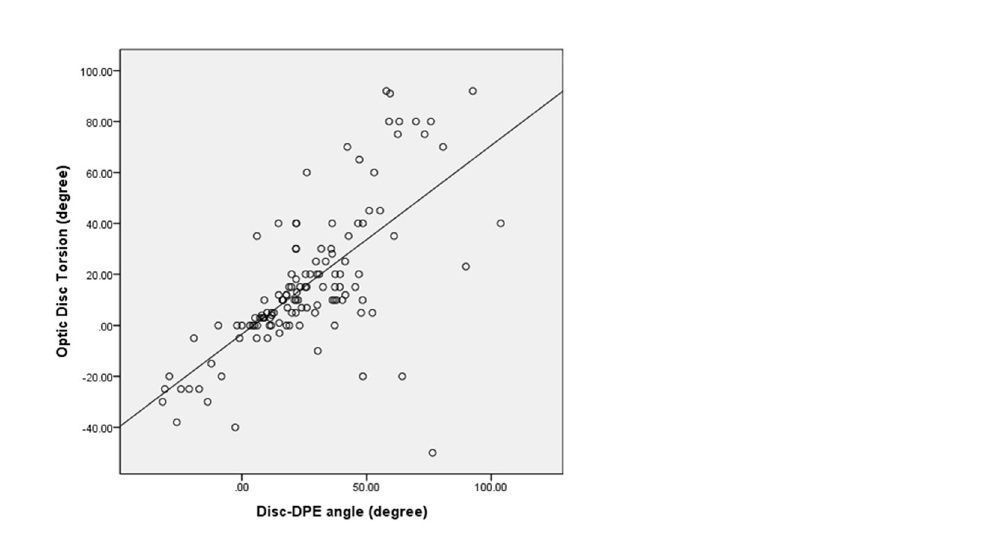
Figure 5. Correlation between the Disc-DPE angle and the disc torsion